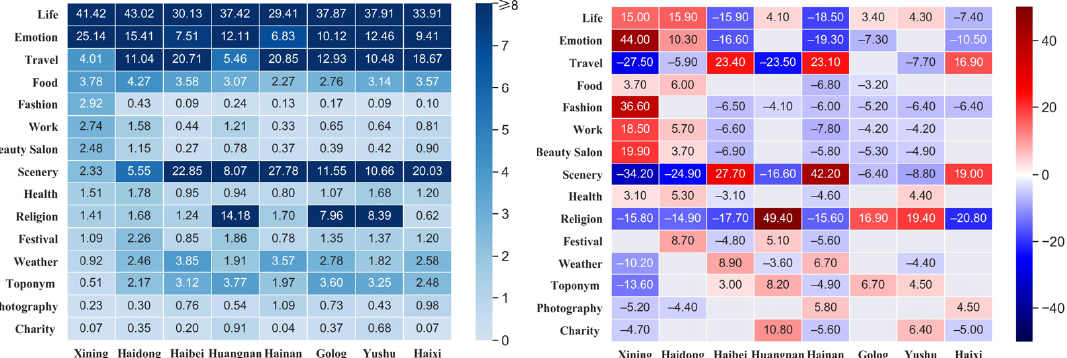
Figure 10. Distributions and adjusted standardized Chi-square residuals for the top 20 topics in the Qinghai tourism dataset by city (unit: %).